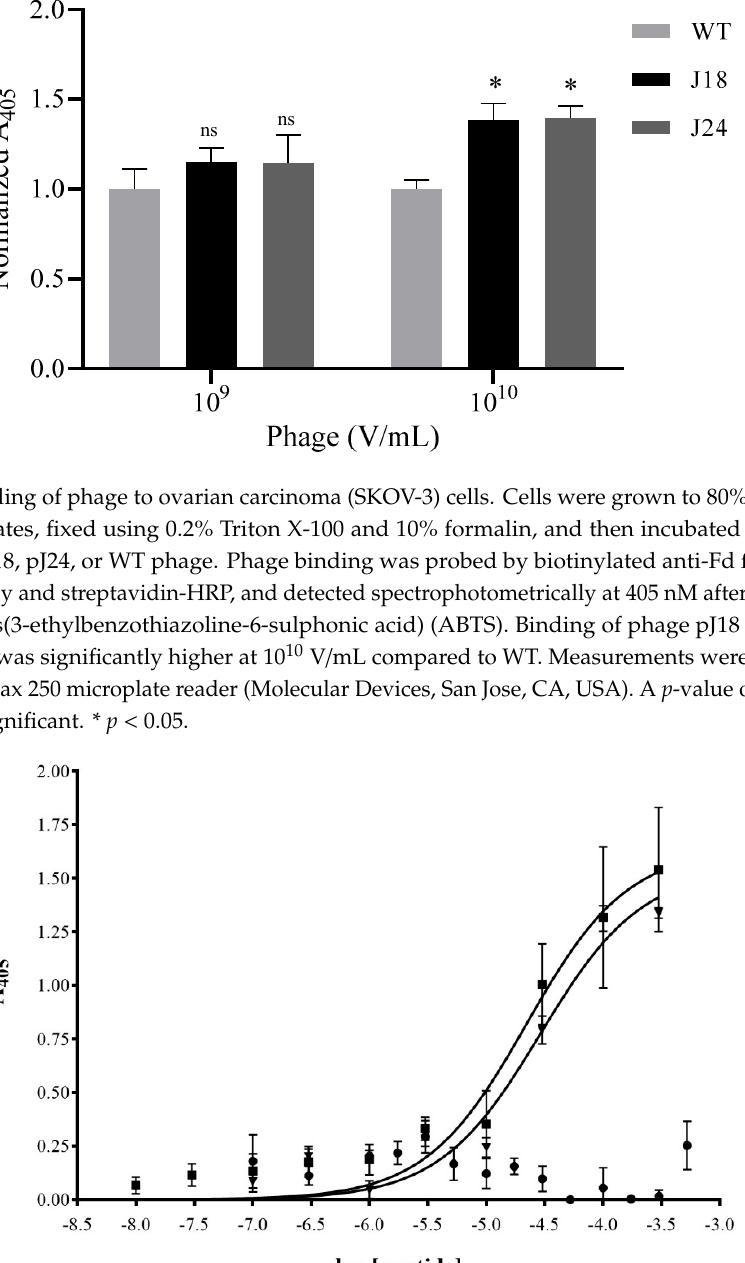
Figure 4. Binding properties of biotinylated peptides J18, J24, and N35 to ovarian carcinoma (SKOV- 3) cells. Cells were grown to 80% confluency on 96-well plates and then incubated with varying concentrations (10 nM to 300 μ M) of J18 ( ■ ), J24 ( ▼ ), and N35 (•) for 1 h at 37 °C. Plates were washed with PBS and fixed with 10% formalin. Biotinylated peptides were detected by HRP-conjugated